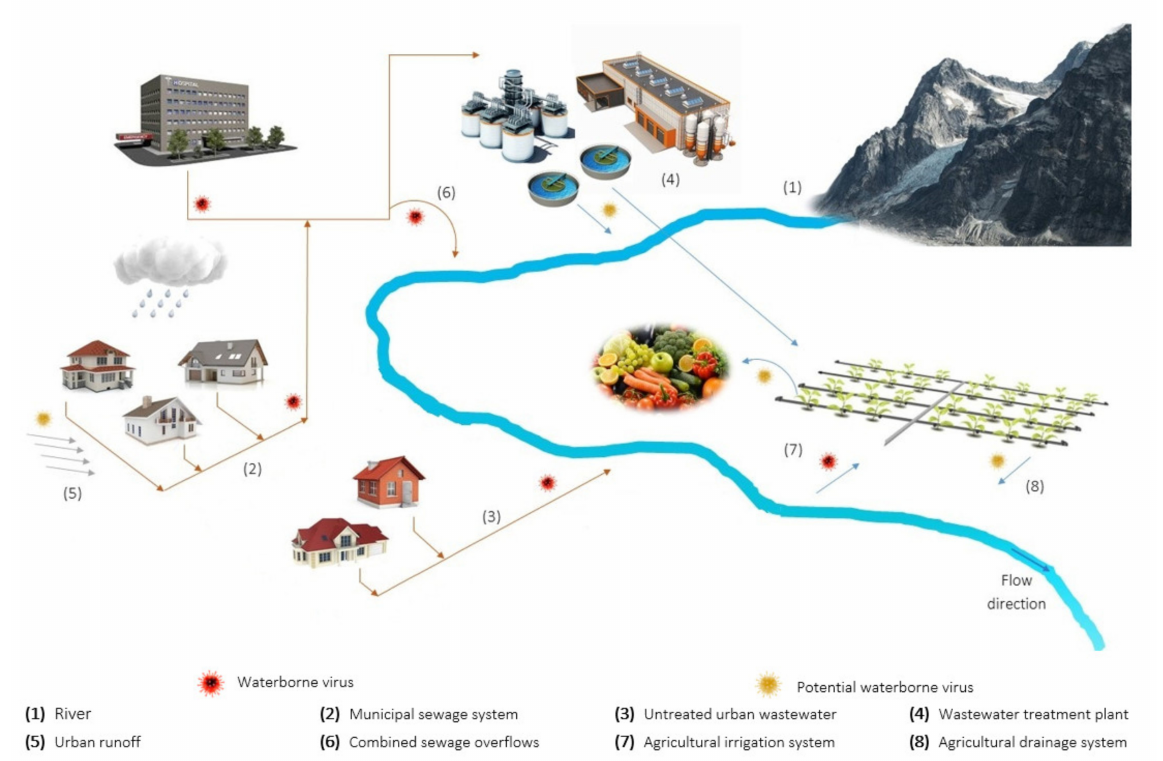
Figure 1. Schematic representation of possible SARS-CoV-2 pathways within the urban and agricultural water